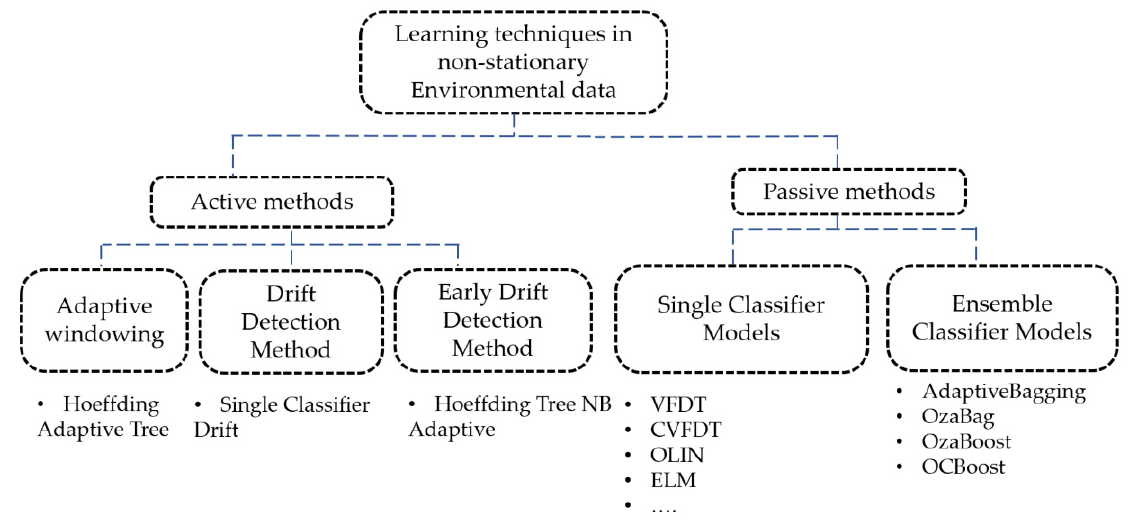
Figure 1. Learning techniques in non-stationary environmental data .